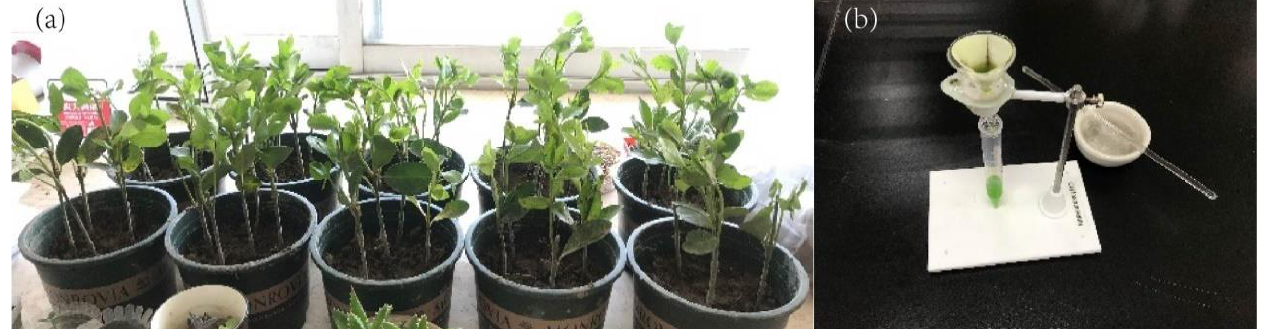
Figure 8. ( a ) Plant culture; ( b ) chlorophyll extraction.